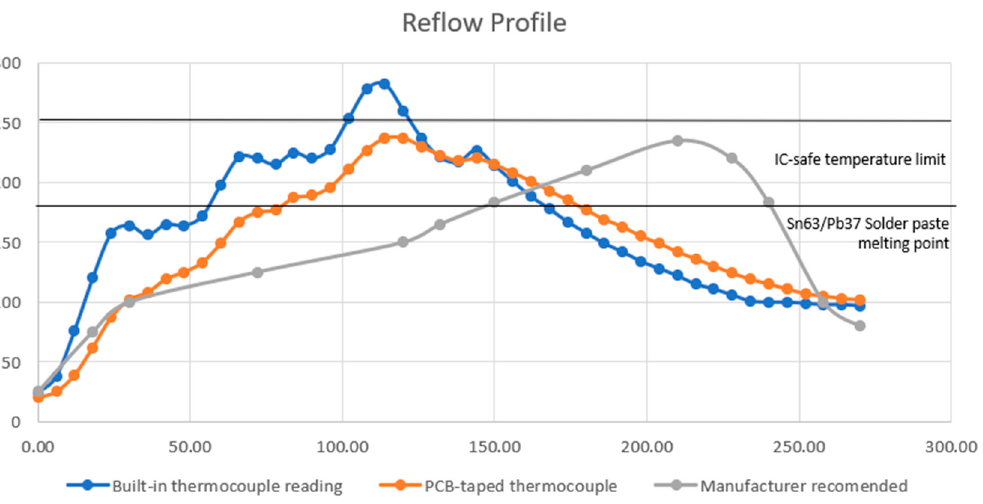
Figure 12. Reflow profile graphic. Offset is evident between the built-in ambient thermocouple (faulty reading) and the one taped directly onto the copper board (actual reading). The gray curve represents the recommended reflow profile.